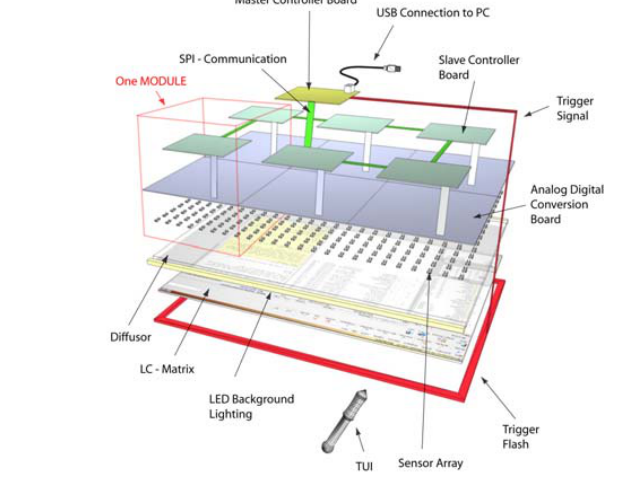
Figure 5. Principle setup of the MightyTrace